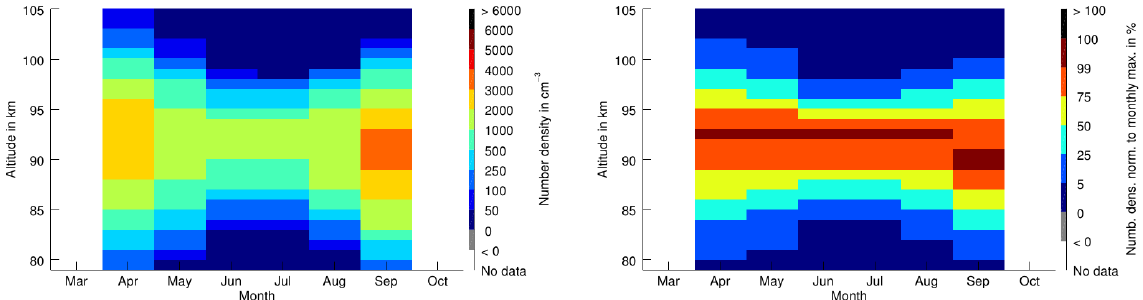
Figure 17. Left: monthly mean Na number densities at 71 ◦ N. Right: profiles of the left figure normalized by the peak densities of each month.